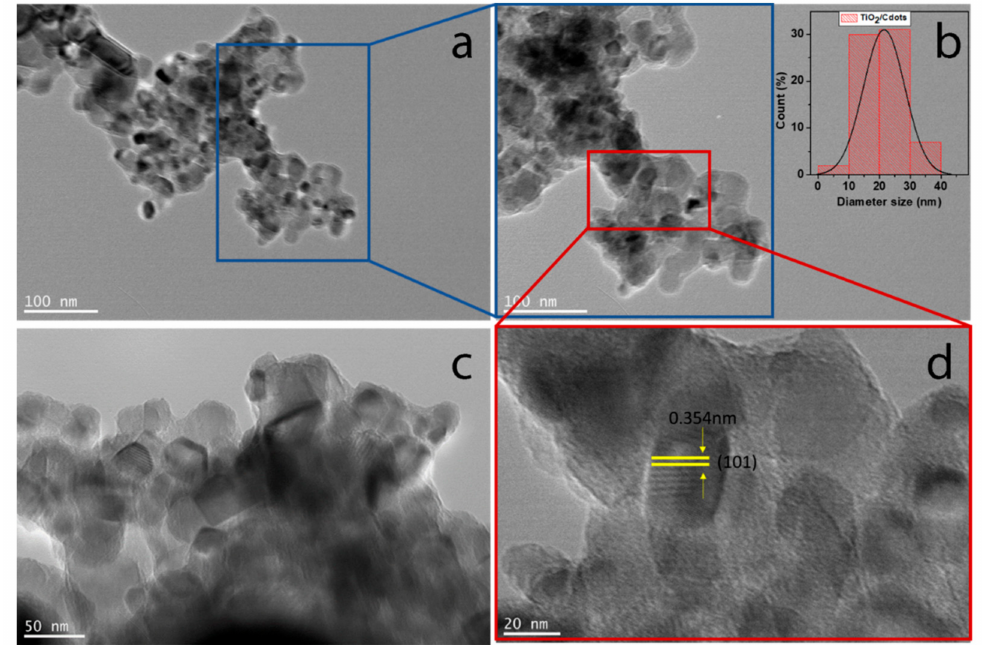
Figure 7. TEM images of TiO 2 enriched with C-dots: ( a , c ) image captured from random areas; ( b , d ) magnified images of the area selected at ( a ).